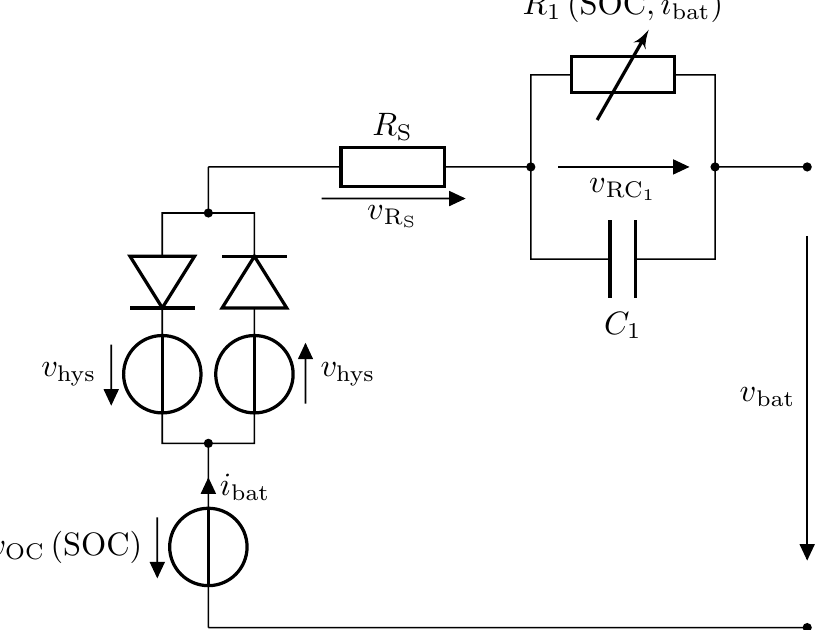
Figure 2. ECM of a battery consisting of an SOC-dependent voltage source, a hysteresis voltage drop, a series resistor, and an RC